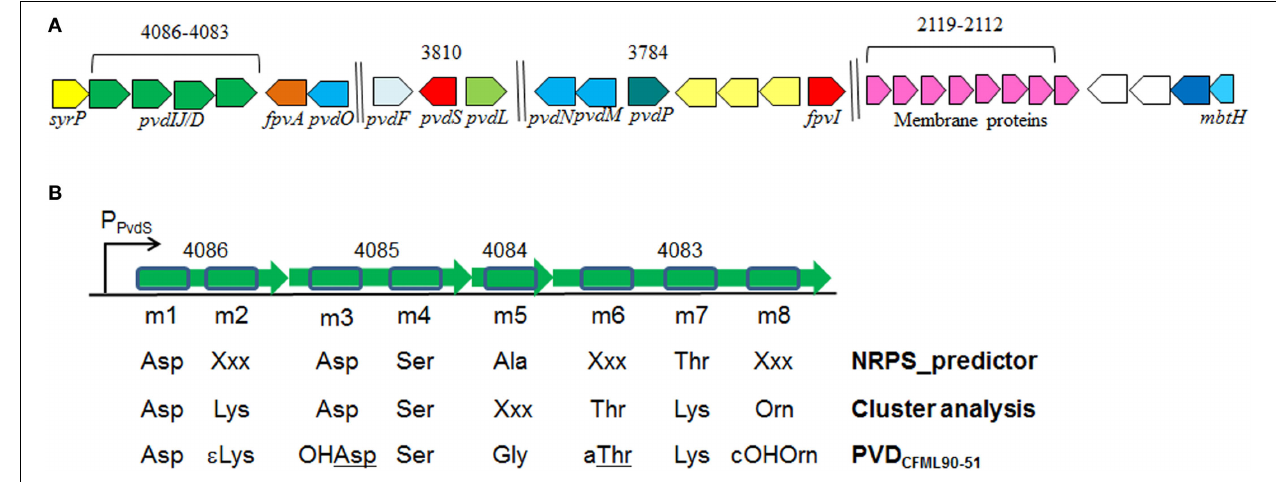
FIGURE 1 | (A) Clusters of putative genes likely to be involved in PVD synthesis in P. putida GB-1. Identification is based on in silico comparison to known PVD-related genes, as described in the text. Genes are annotated according to Ravel and Cornelis (2003). Color schemes are based on Ravel and Cornelis (2003). Numbers on top are locus tags for P. putida GB-1 (PputGB1 numbers). Length is not to scale. (B) The 8